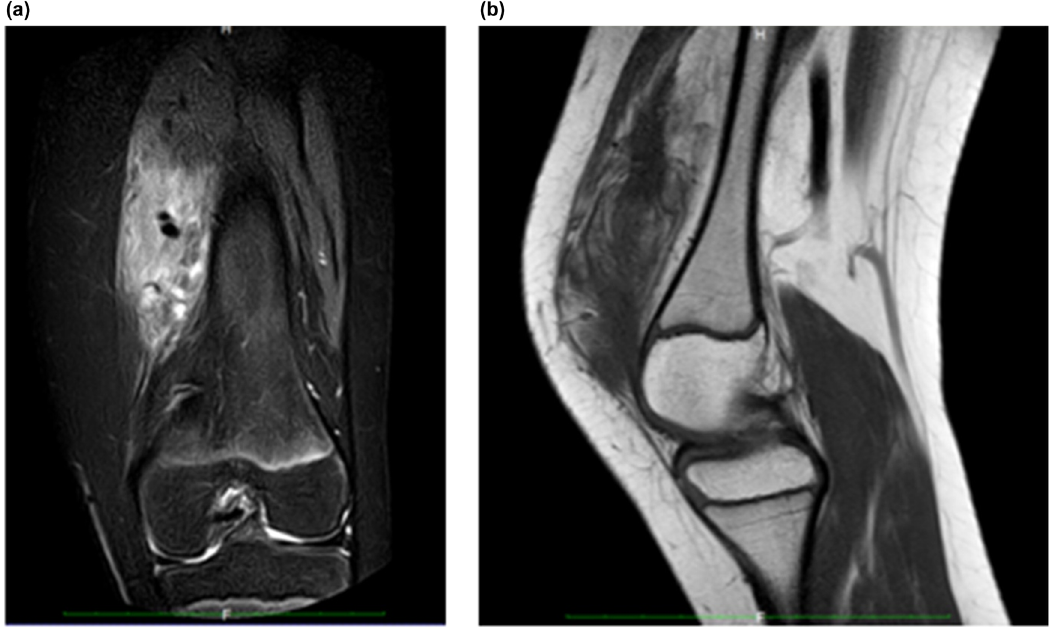
Figure 5: Pre - and postoperative magnetic resonance imaging showing signi fi cant improvement in the adipose and vascular components. ( a ) Preoperative; ( b ) at 12 months ’